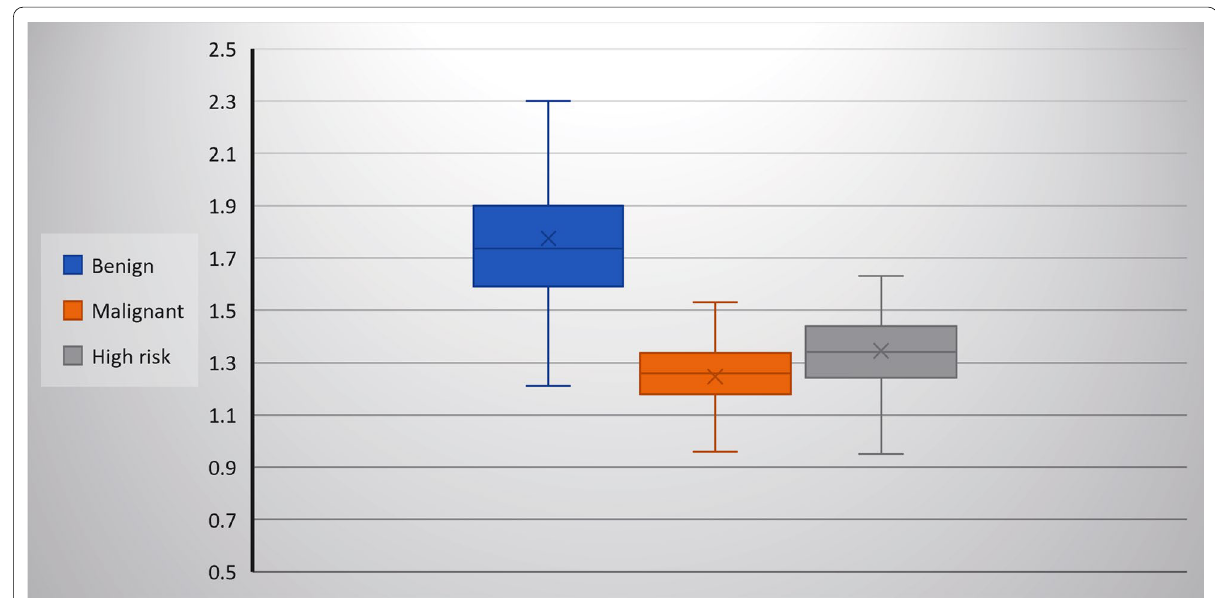
Fig. 1 Chart showing a comparison between ADC values of 150 benign breast changes, 68 high‑risk breast lesions, and 150 malignant breast lesions